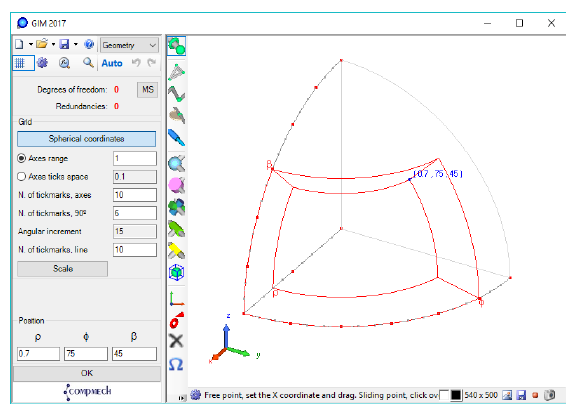
Figure 4. Spatial joints implemented in GIM.